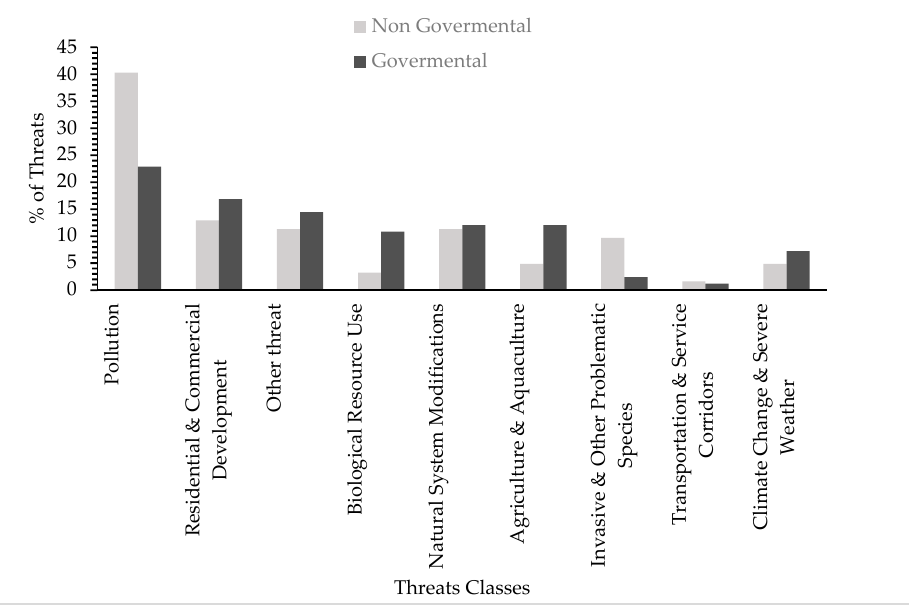
Figure 3. Frequency of direct threats identified by governmental and non-governmental stakeholders in the Gediz Delta based on the IUCN threat classification system (30 ind).